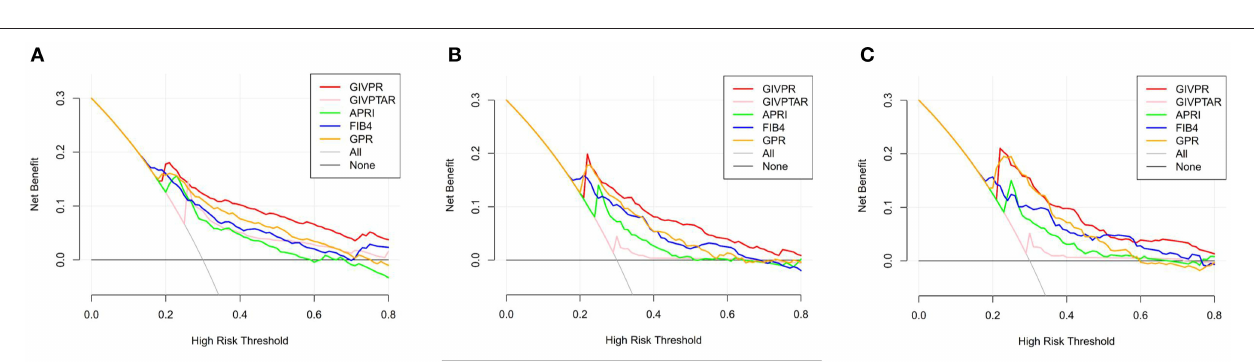
FIGURE 5 | Liver fibrosis decision curve analysis in training set. Decision curve analysis depict the clinical net benefit. GIVPR is compared with GIVPTAR, APRI, FIB-4, and GPR for predicting significant fibrosis (A) ; GIVPR is compared with GIVPTAR, APRI, FIB-4, and GPR for predicting advanced fibrosis (B) ; GIVPR is compared with GIVPTAR, APRI, FIB-4, and GPR for predicting cirrhosis (C) . Black line, net benefit when no patient will experience the event; gray line, net benefit when all patients will experience the event. The preferred markers is the marker with the highest net benefit at any given threshold.